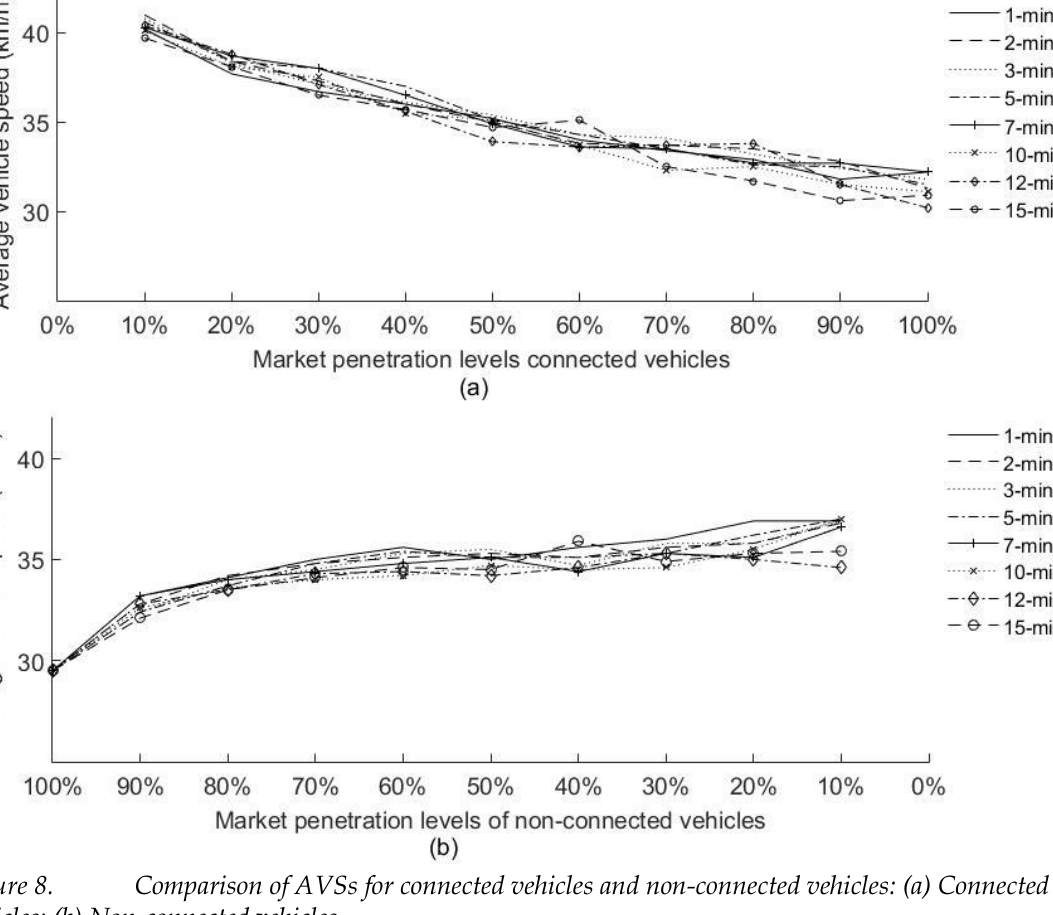
Figure 8. Comparison of AVSs for connected vehicles and non-connected vehicles: (a) Connected vehicles; (b) Non-connected